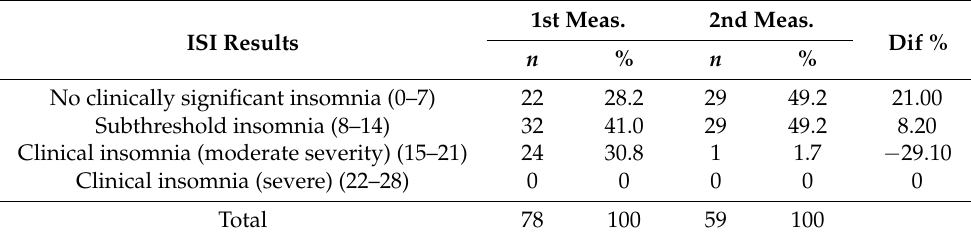
Table 2. Frequency of ISI scores.